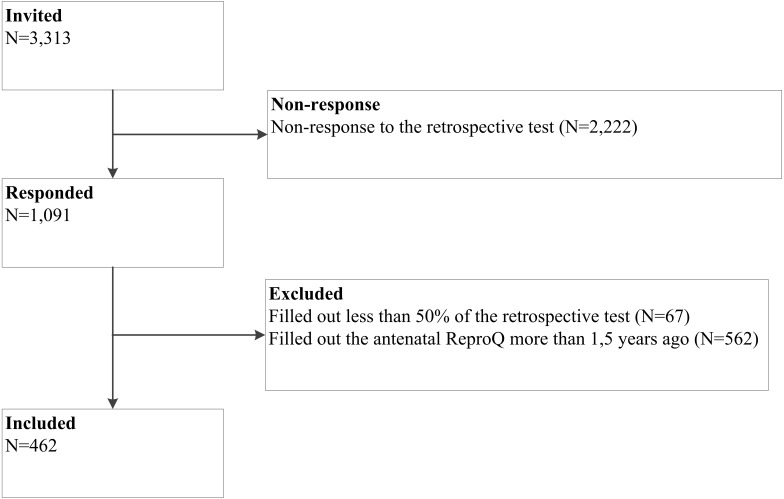
Flow diagram of study.